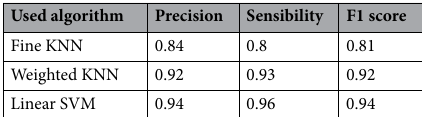
Table 13. Performances of the used algorithms.